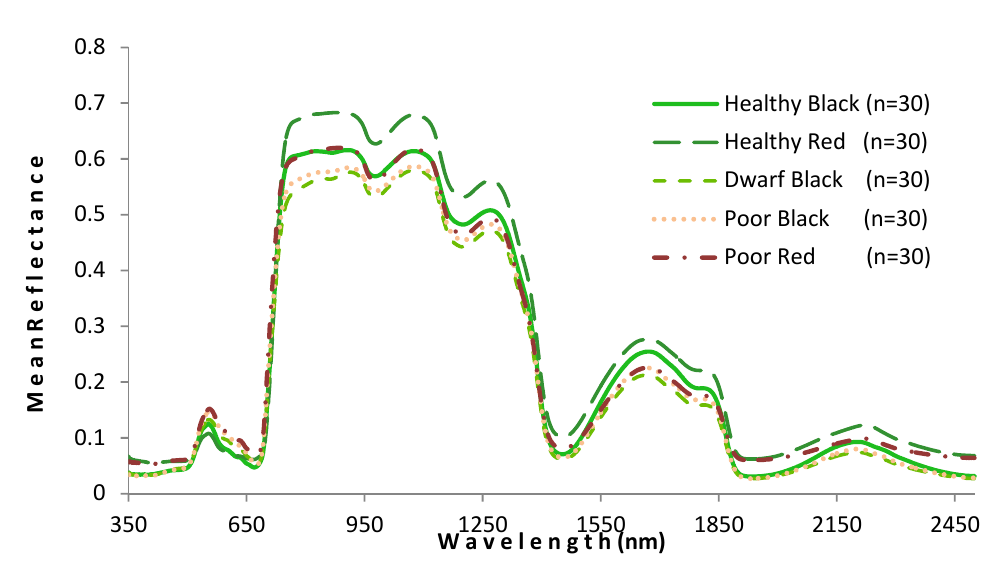
Figure 5. Mean spectral curves recorded for two mangrove species located near Mazatlan,